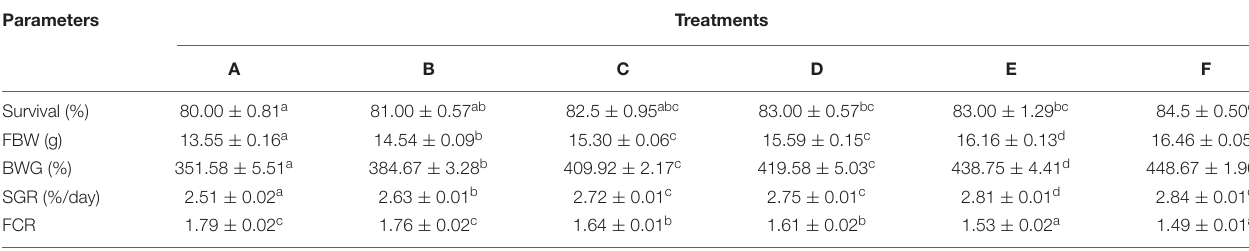
TABLE 3 | Growth parameters and nutrient utilization of P. monodon fed with experimental diets for 56 days. #